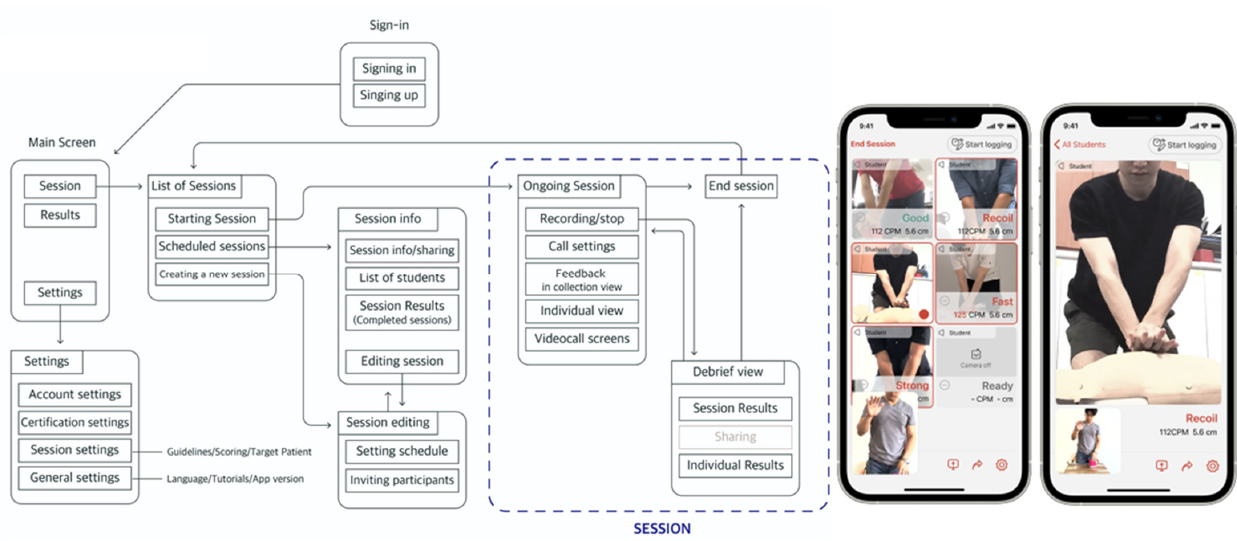
Figure 4. Flow map ( left ) and User Interface ( right ) of Instructor application.